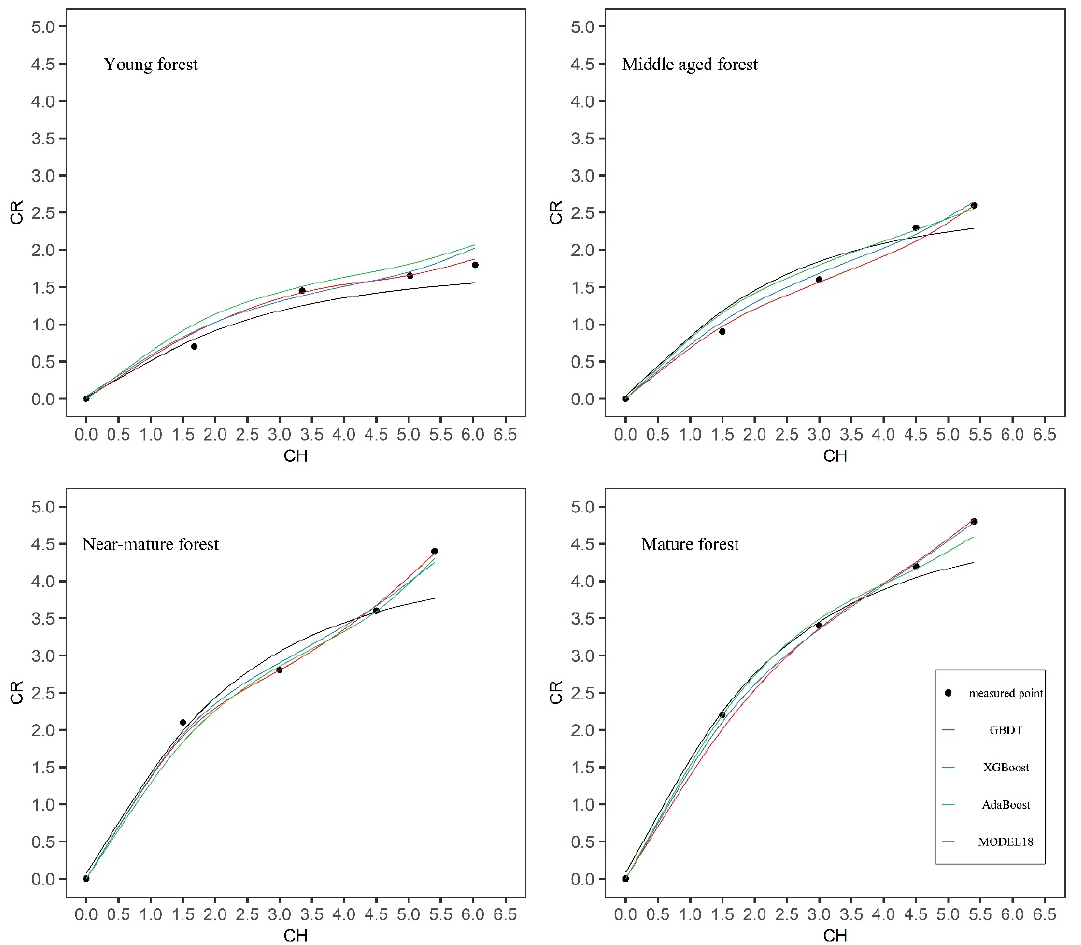
Figure 6. Theoretical and actual values of crown profile for Chinese fir trees in four age groups (young forest tree: DBH = 9.9, TH = 8.5, AGE = 8; middle aged forest tree: DBH = 13.0, TH = 10.0, AGE = 14; near-mature forest tree: DBH = 17.7, TH = 12.0, AGE = 23; mature forest tree: DBH = 19.2, TH = 17.5, AGE = 35).